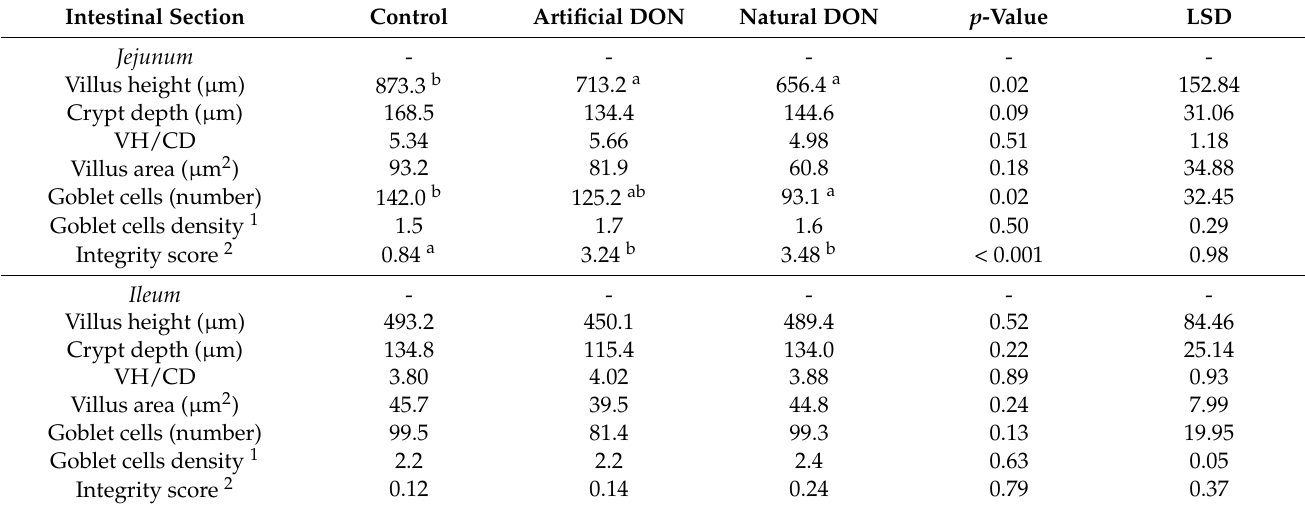
Table 4. Effect of experimental diets on morphometric and morphological parameters in jejunum and ileum from 14-days-old broiler chickens.